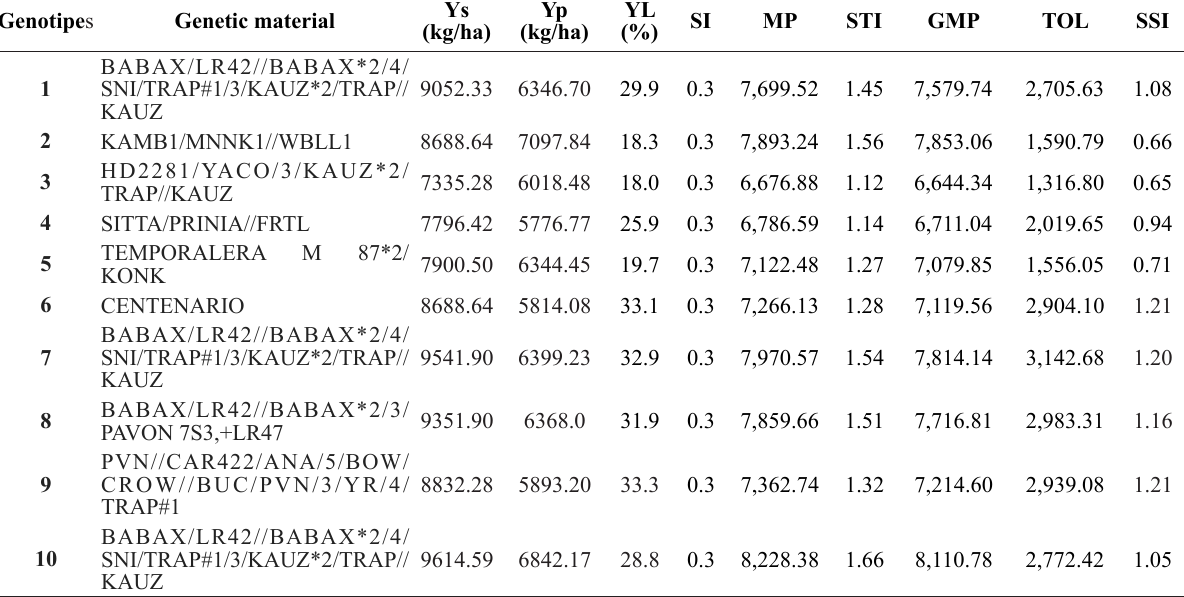
Table 9. Grain yield values under total irrigation conditions (Yp), deficit irrigation (Ys), percentage of yield loss due to drought stress (YL), Stress Susceptibility Index (SSI), Stress Intensity (SI), Tolerance Index, (TOL) Mean Productivity (MP), Geometric Mean Productivity (GMP), Stress Tolerance Index (STI) of the assessment of tolerant wheat genotypes ( Triticum aestivum L.) to drought in conditions of La Molina LM 2019B.